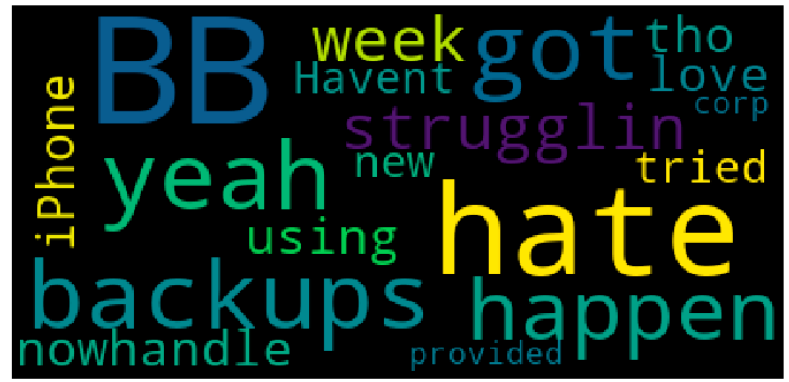
Figure 13. Word Cloud of Non-Aggressive Class.